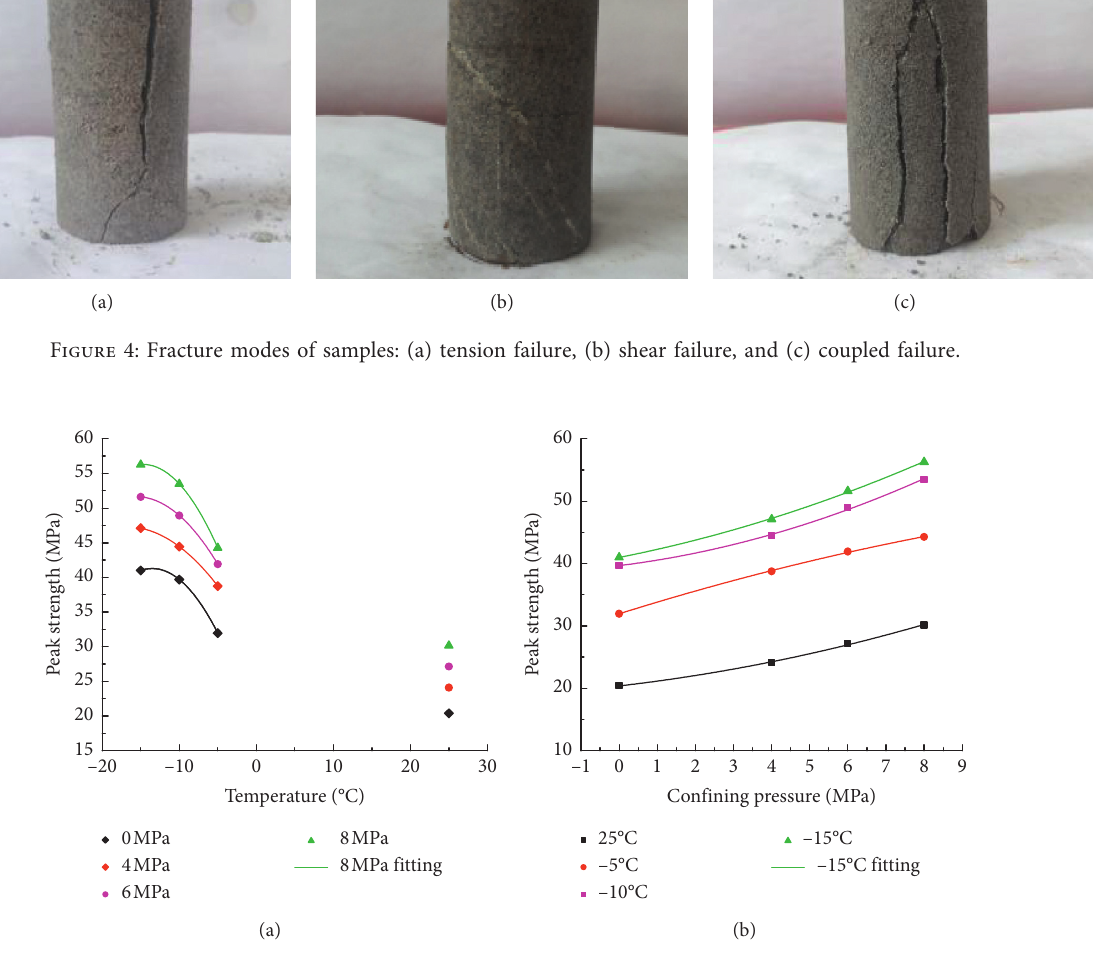
Figure 5: Peak strength curves under different conditions: (a) temperature and (b) confining pressure. Table 2: Cohesion and internal friction angle at different